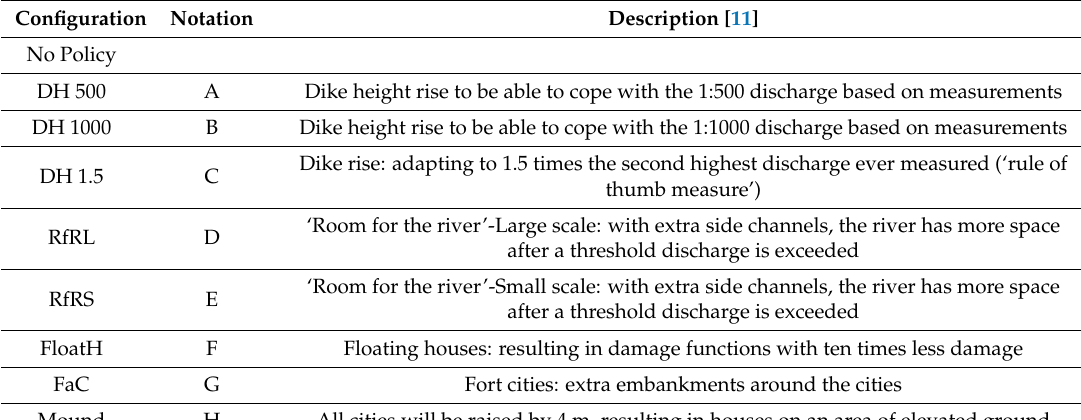
Table 2. Portfolio of Adaptation Actions, Waas case study (Table adapted from [11]).